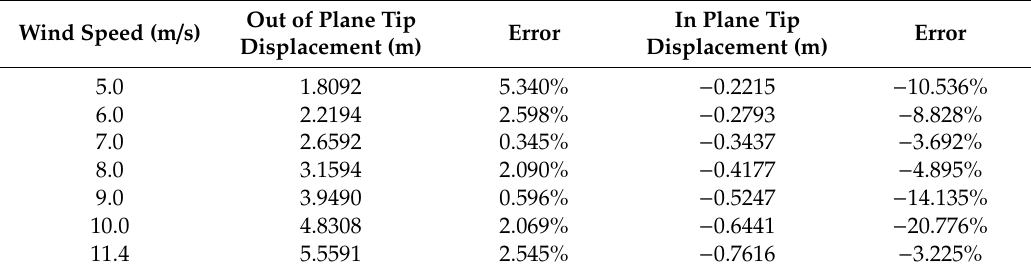
Table 9. Comparison of the tip displacement relative errors between elastic actuator line model (EALM)